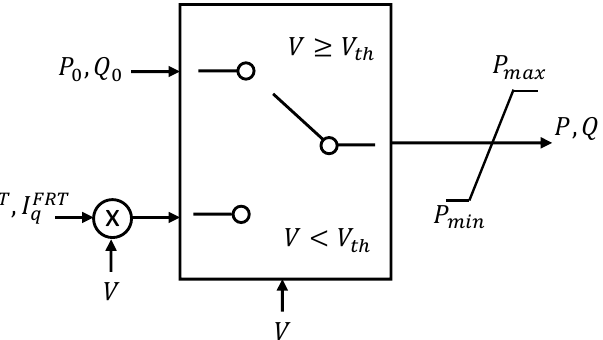
Figure 5. Converter-interfaced renewable energy source power control model (adapted from [30]).